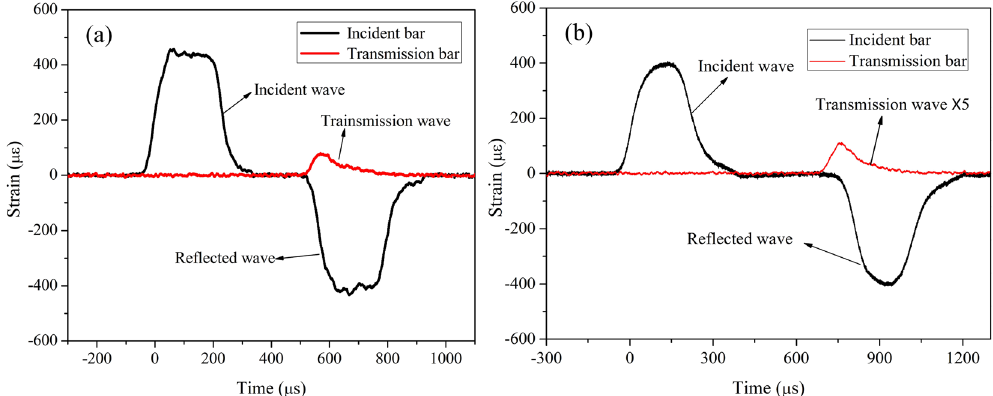
Figure 7. Typical incident, reflected, and transmitted waves in SPHB tests: ( a ) concrete and ( b ) mortar BD specimens, where the transmitted wave signal in the latter is amplified five times for